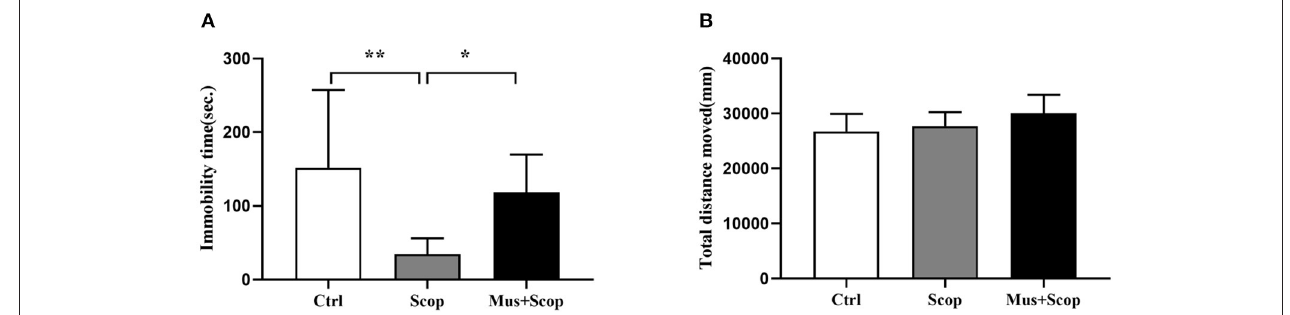
FIGURE 2 | Results for effects of scopolamine on animal behaviors. (A) compared with saline group, scopolamine significantly reduces immobility time in the FST in rats, but after silencing of neurons in the mPFC by muscimol, the immobility time of scopolamine is significantly increased compared with scopolamine only. (B) total distance among the three groups shows no significant difference. n = 10/group; Crtl: control; Scop: scopolamine; Mus: muscimol; *: p < 0.05; **: p < 0.01.